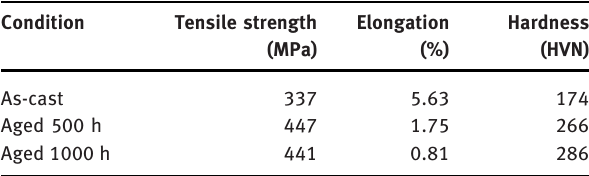
Table 1: Mechanical properties at room temperature.